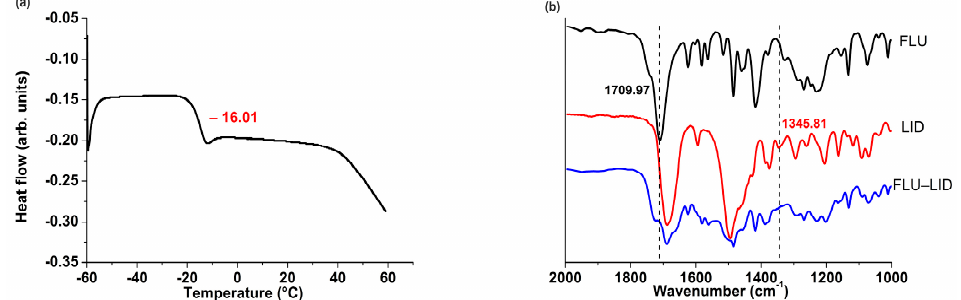
Table 1. 1 H NMR data of FLU, LID and FLU-LID ILs (Chemical shift, ppm).